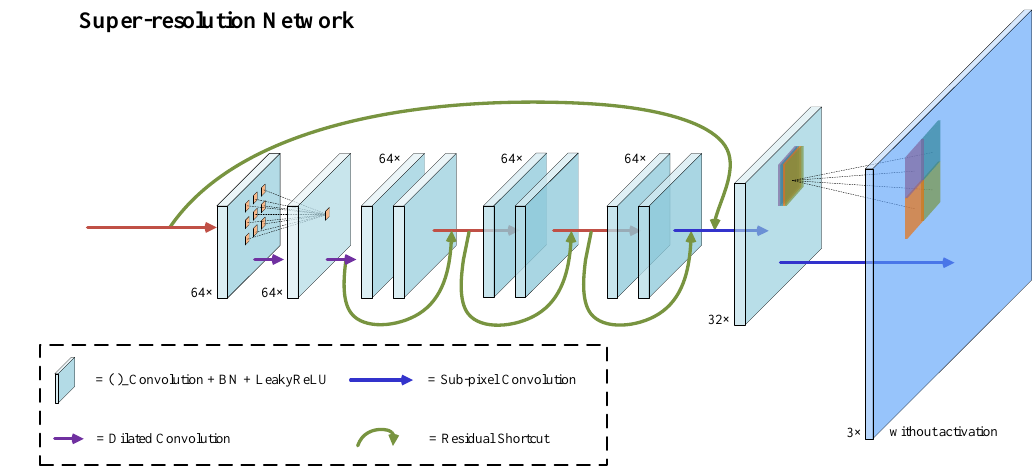
Figure 9. Super-Resolution generation model. The light blue square in the figure indicates a certain type of convolutional layer, batch normalization layer and activation layer. The purple arrow indicates that the convolution type of the corresponding layer is a dilated convolution, and the blue arrow indicates a sub-pixel convolution; the green arc arrow indicates the residual shortcut. The last dark color layer has no activation.